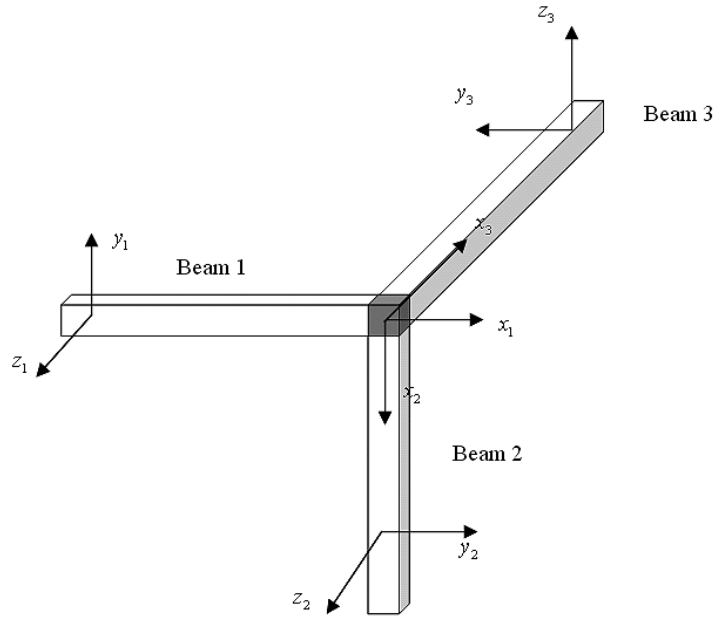
Fig. 8. Three semi-infinite Timoshenko beam structure coupled at three-dimensional